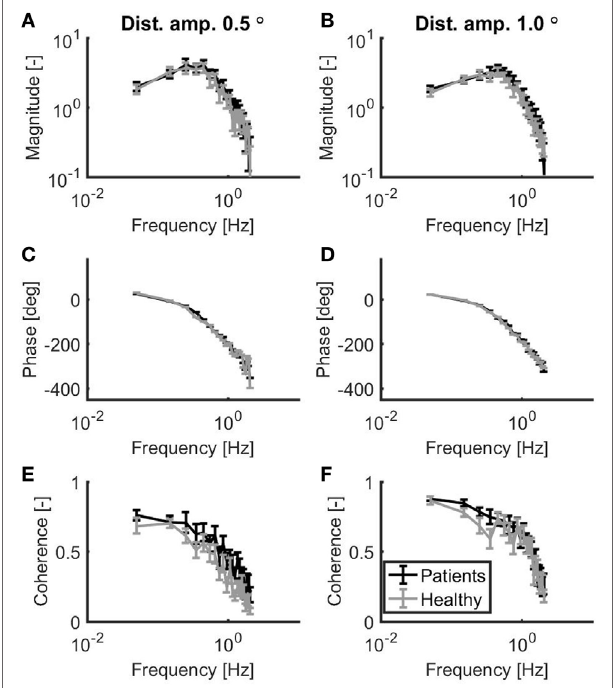
FigUre 2 | Mean magnitude (a,B) and mean phase (c,D) of the sensitivity functions as well as the mean coherence (e,F) for a peak-to-peak disturbance amplitude of 0.5° (a,c,e) and 1.0° (B,D,F) . Patients with vestibular dysfunction and healthy subjects are represented by black and gray lines, respectively. Error bars represent